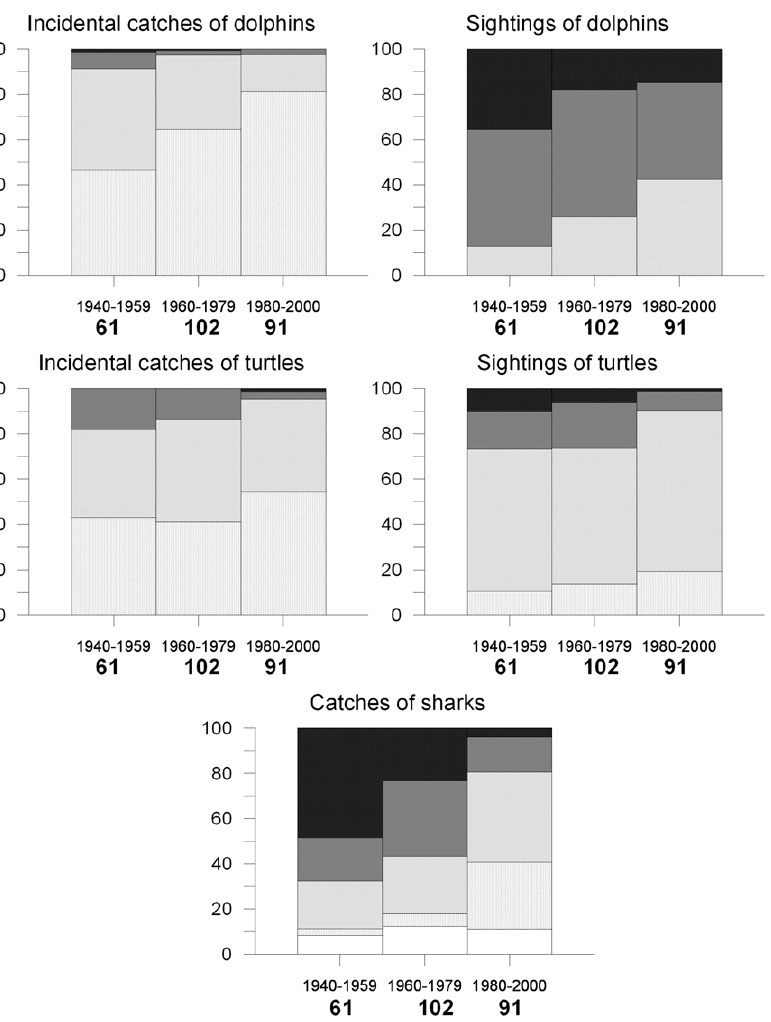
Figure 4. Trends in catches and sightings of large marine fauna, all areas combined. Frequencies in the responses to questions on catches or sightings of large marine fauna combining the different Mediterranean case studies, by time period.